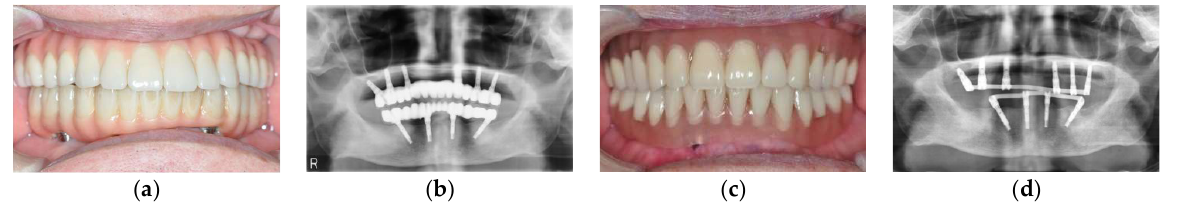
Figure 2. A case of suprastructure conversion (86 years old at baseline, male): ( a ) intraoral view with fixed prostheses; ( b ) panoramic image with fixed prostheses; ( c ) intraoral view with removable pros- theses (implant overdentures); ( d ) panoramic image with bar attachments for implant overdentures.